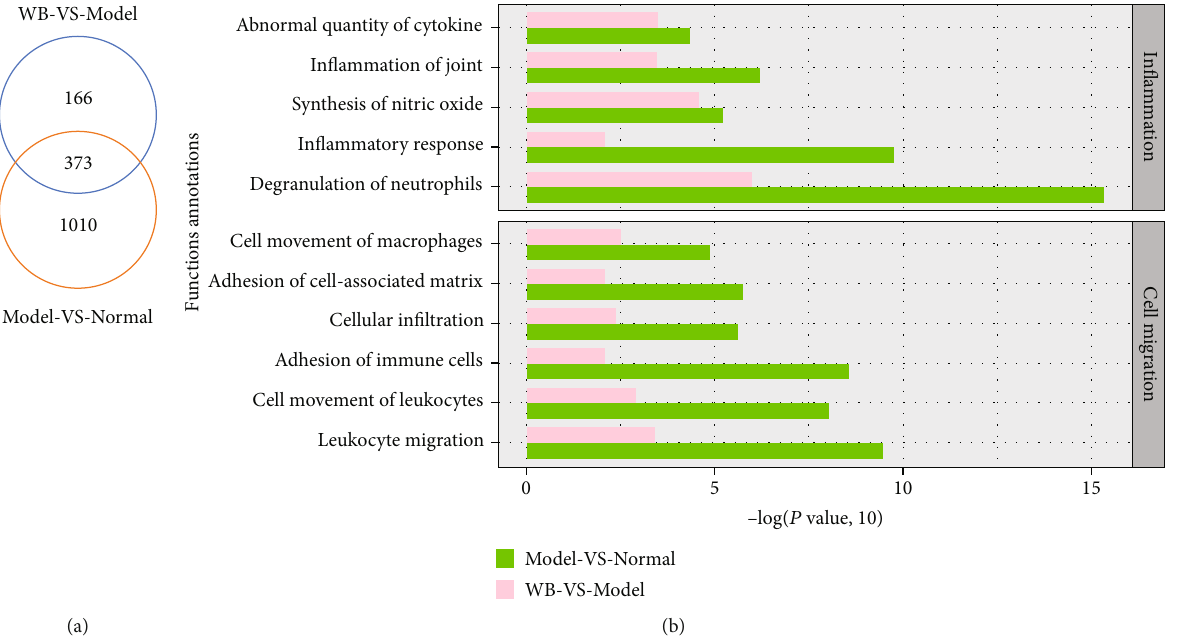
Figure 4: The biofunction analysis of DEPs in WB vs. model and model vs. normal. (a) The Venn diagram of DEPs of WB vs. model and model vs. normal. (b) The top function enrichment annotations in in fl ammation and cell migration were screened with − log ð P value, 10 Þ ≥ 1 : 3